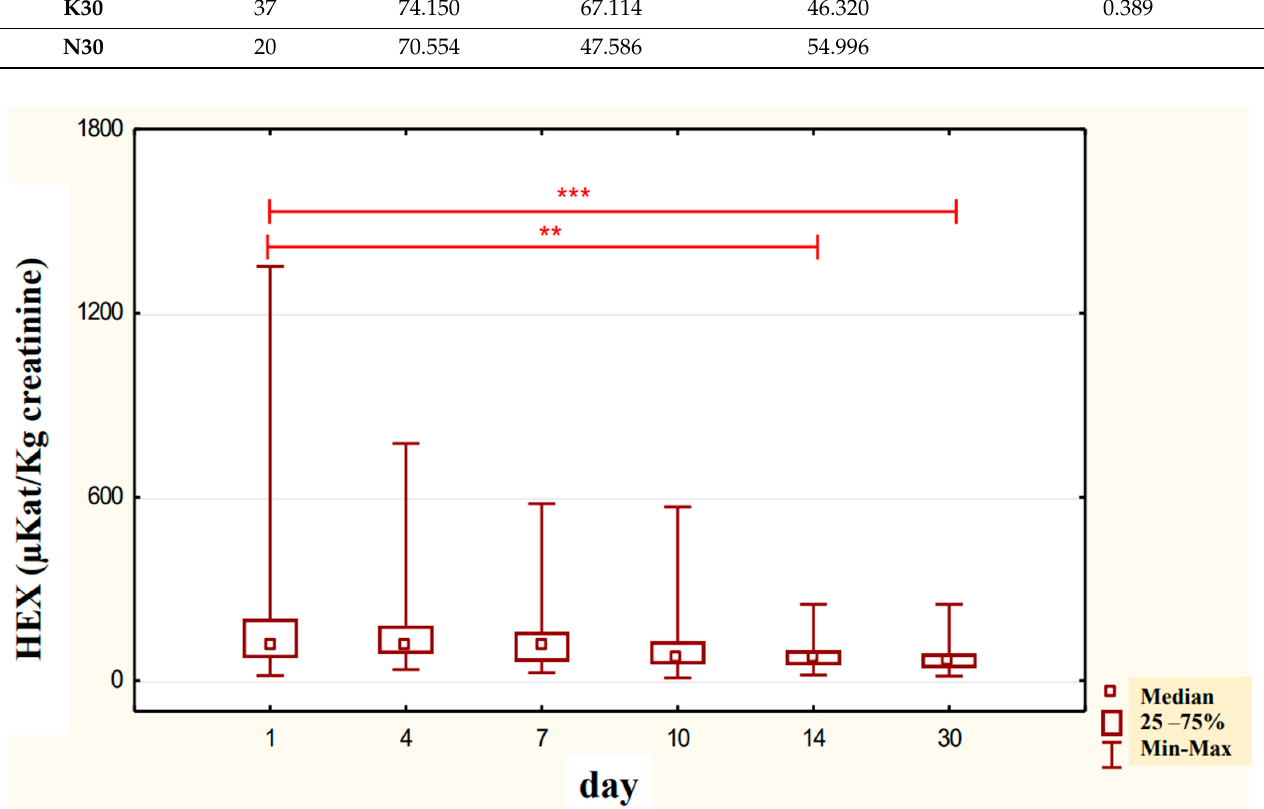
Figure 7. Urinary HEX specific activity ( μ Kat/kg creatinine) of control group patients (K), in subjects who were addicted to alcohol but not treated with neoglandin; ** p < 0.01, *** p < 0.001.